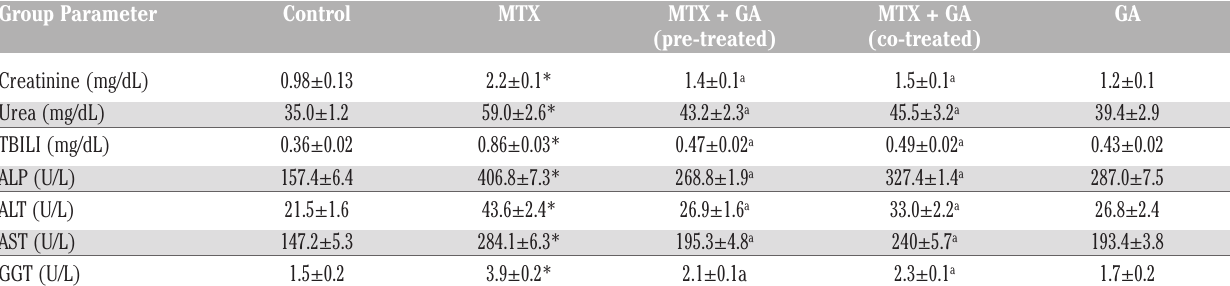
Table 2. Ameliorative effect of gallic acid pre-treatment and co-treatment on methotrexate-induced changes in plasma biomarkers of renal and hepatic function in rat. Group